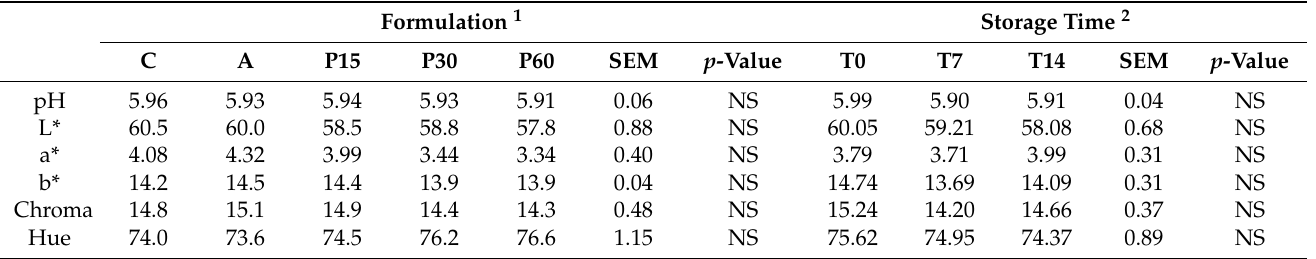
Table 5. Estimated marginal means and standard error of the mean (SEM) of the pH, and color parameters of the cooked pork